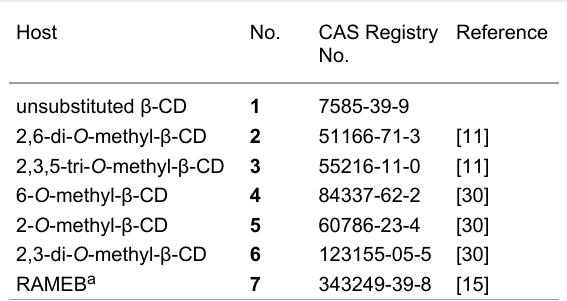
Table 3: List of the methylated β -CD derivatives used in this contribu- tion. Host No. CAS Registry